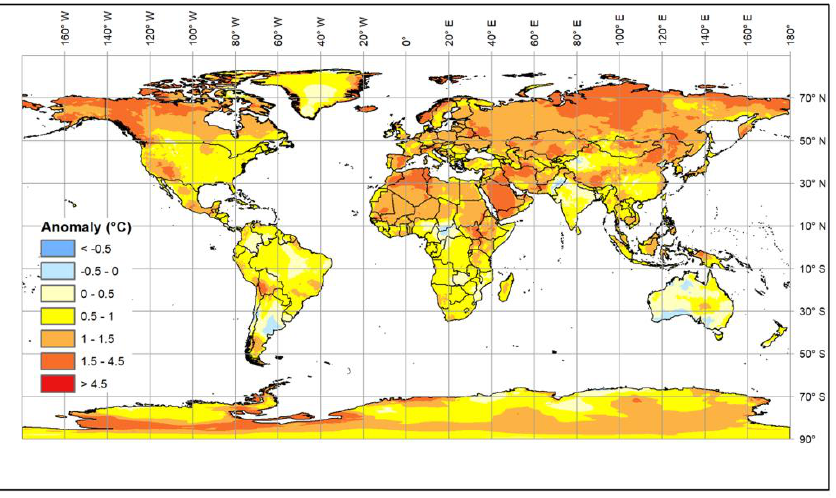
Figure 1. Map of annual temperature changes in the period 1992–2020 compared to 1950–1978, created using ERA5 climate Reanalysis tools. The areas showing warming are in yellow-red and those showing cooling are in blue.